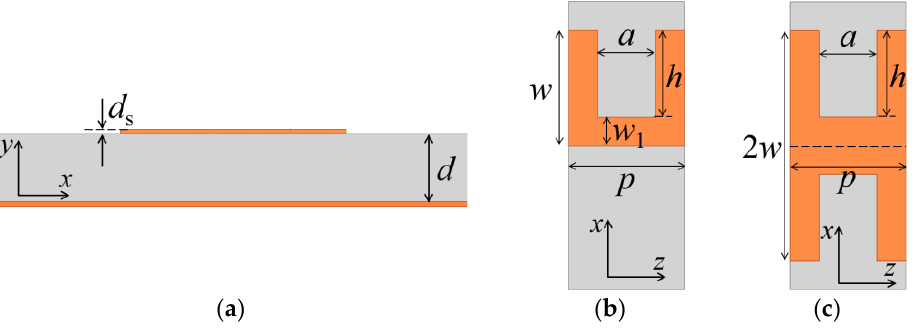
Figure 1. Configuration of the corrugated SWTL: ( a ) cross-sectional view; ( b ) top view of the U- shaped unit; ( c ) top view of the H-shaped unit.